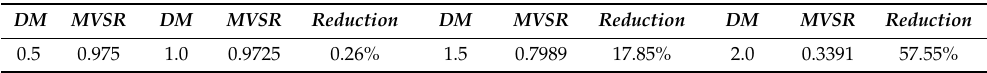
Table 2. The maximum value of system reliability ( MVSR ) results for varied demand multiplier ( DM ) values.